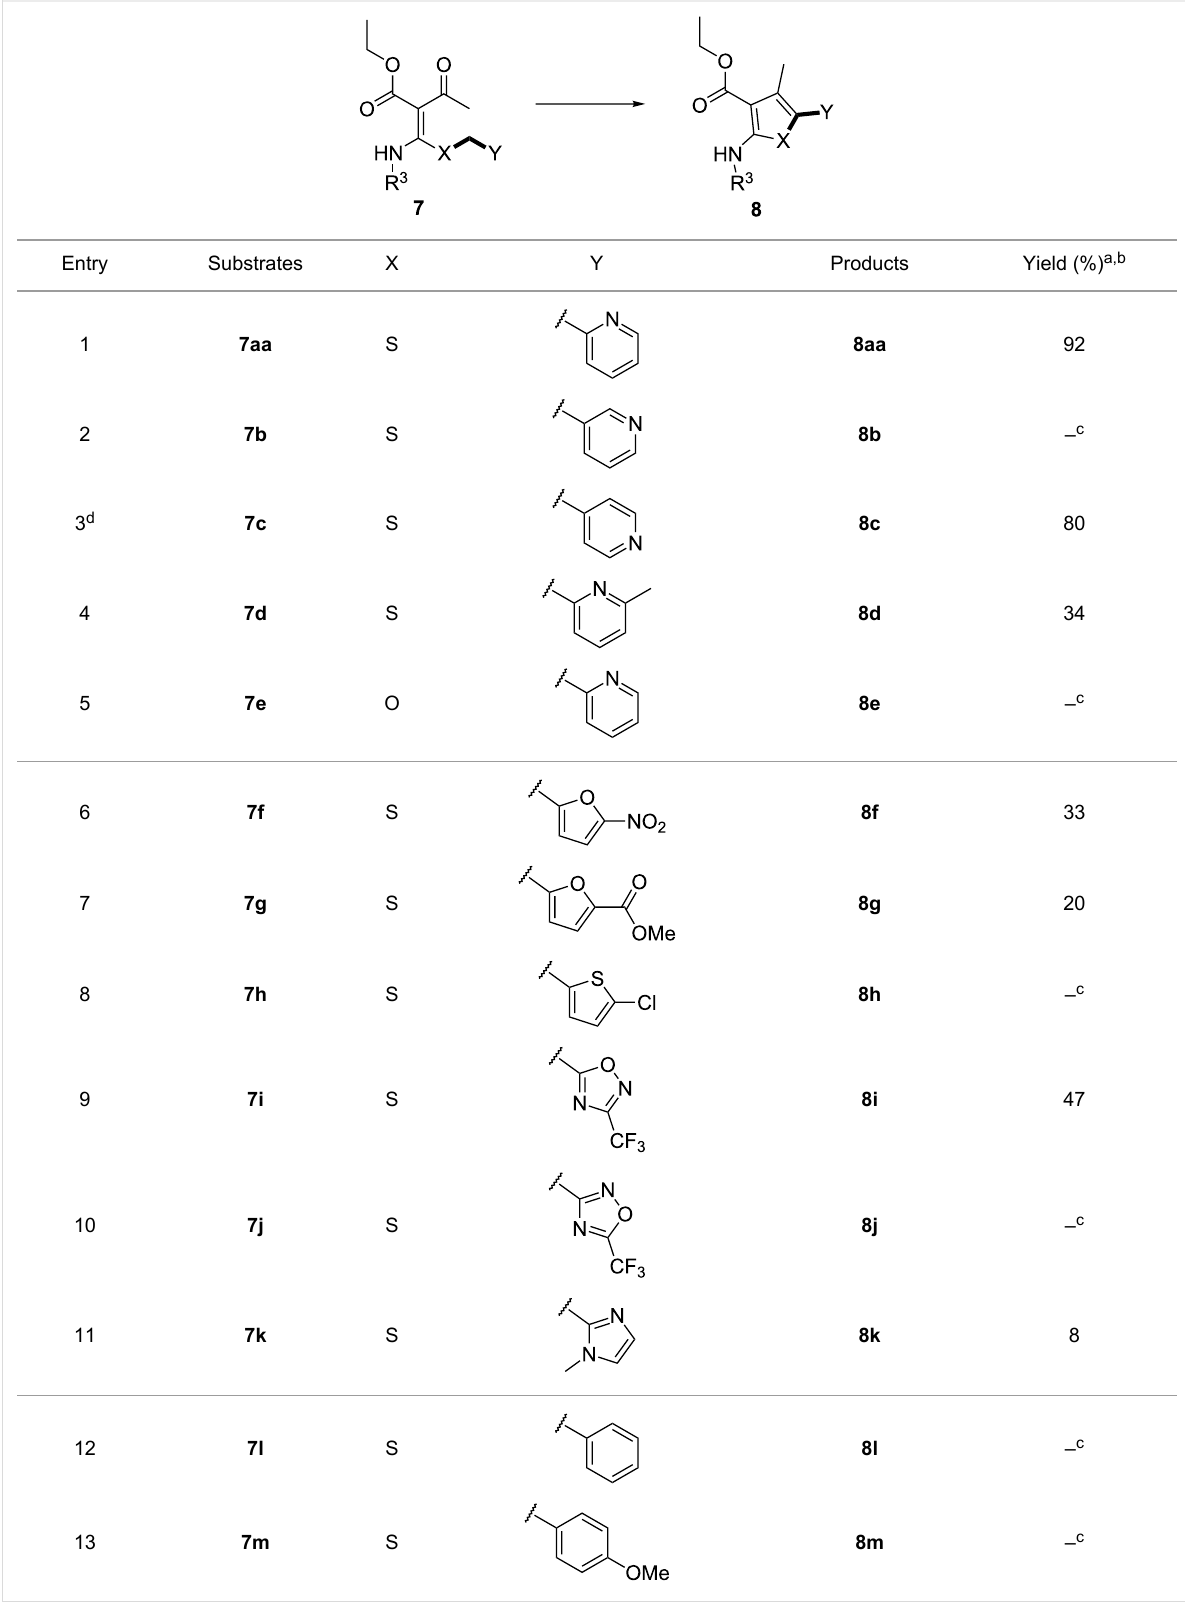
Table 1: Examination of N , S -acetals substituted with a heterocycle ( 7aa–k ) or an arene ( 7l–p